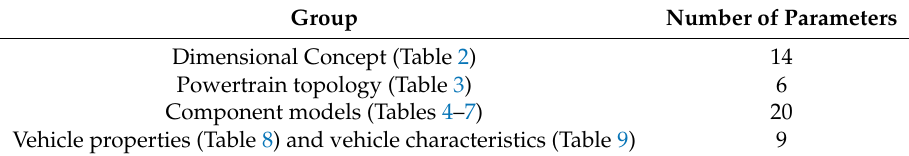
Table 10. Minimum set of design parameters for the early development of BEV